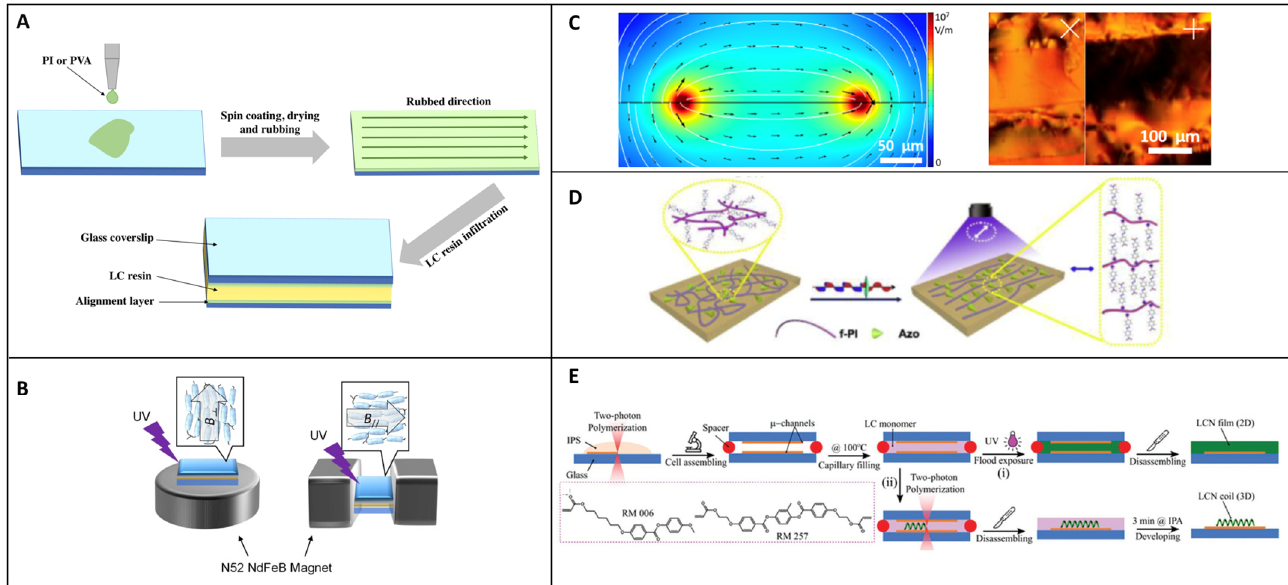
Figure 1. Phase transition behavior for a nematic LC with an increase in temperature.